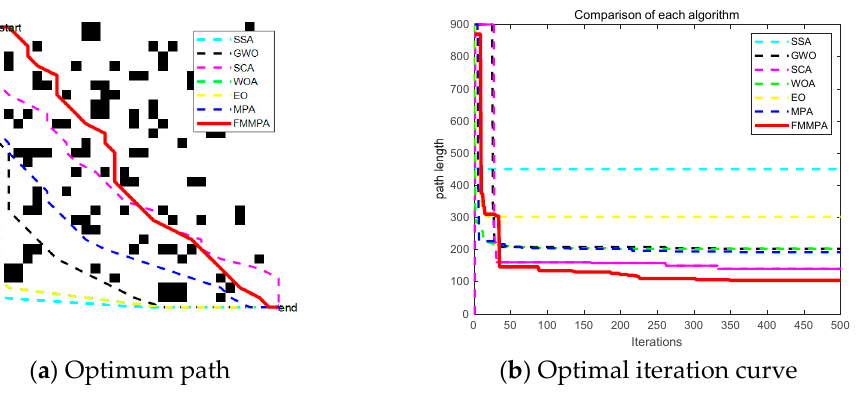
Figure 8. Experimental results for map 2.